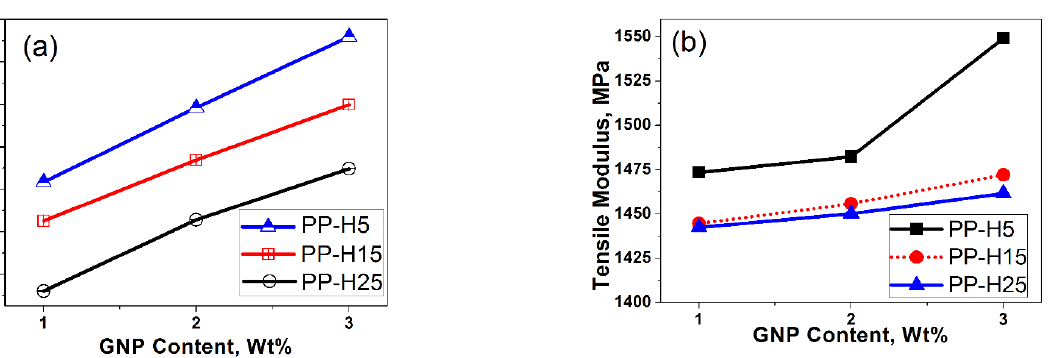
Figure 3. Dependence of ( a ) tensile strength and ( b ) tensile modulus on the amounts of GNPs, and their lateral sizes. Table 3. Extracted data referring to mechanical strength.